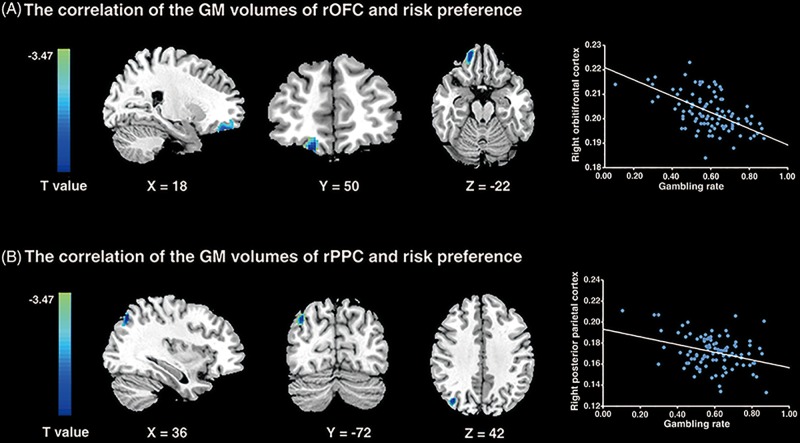
VBM results. (A) The gambling rates were negatively correlated with the GM volumes in the right orbitofrontal cortex (p < 0.001; small volume corrected). (B) The similar correlation was found between risk preference and the GM volumes of the right posterior parietal cortex (p < 0.001; small volume corrected). The scatter plots on the right are presented for visualization and not for statistical inference.